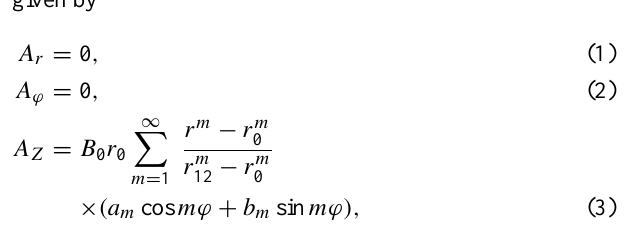
Fig. 1. Geometrical set-up of the considered problem (cut in the Z = 0 plane). The particular case treated in Sect. 3 is displayed, with x 0 =− r 0 . But in general, x 0 can have an arbitrary value (limited by the geometry of the